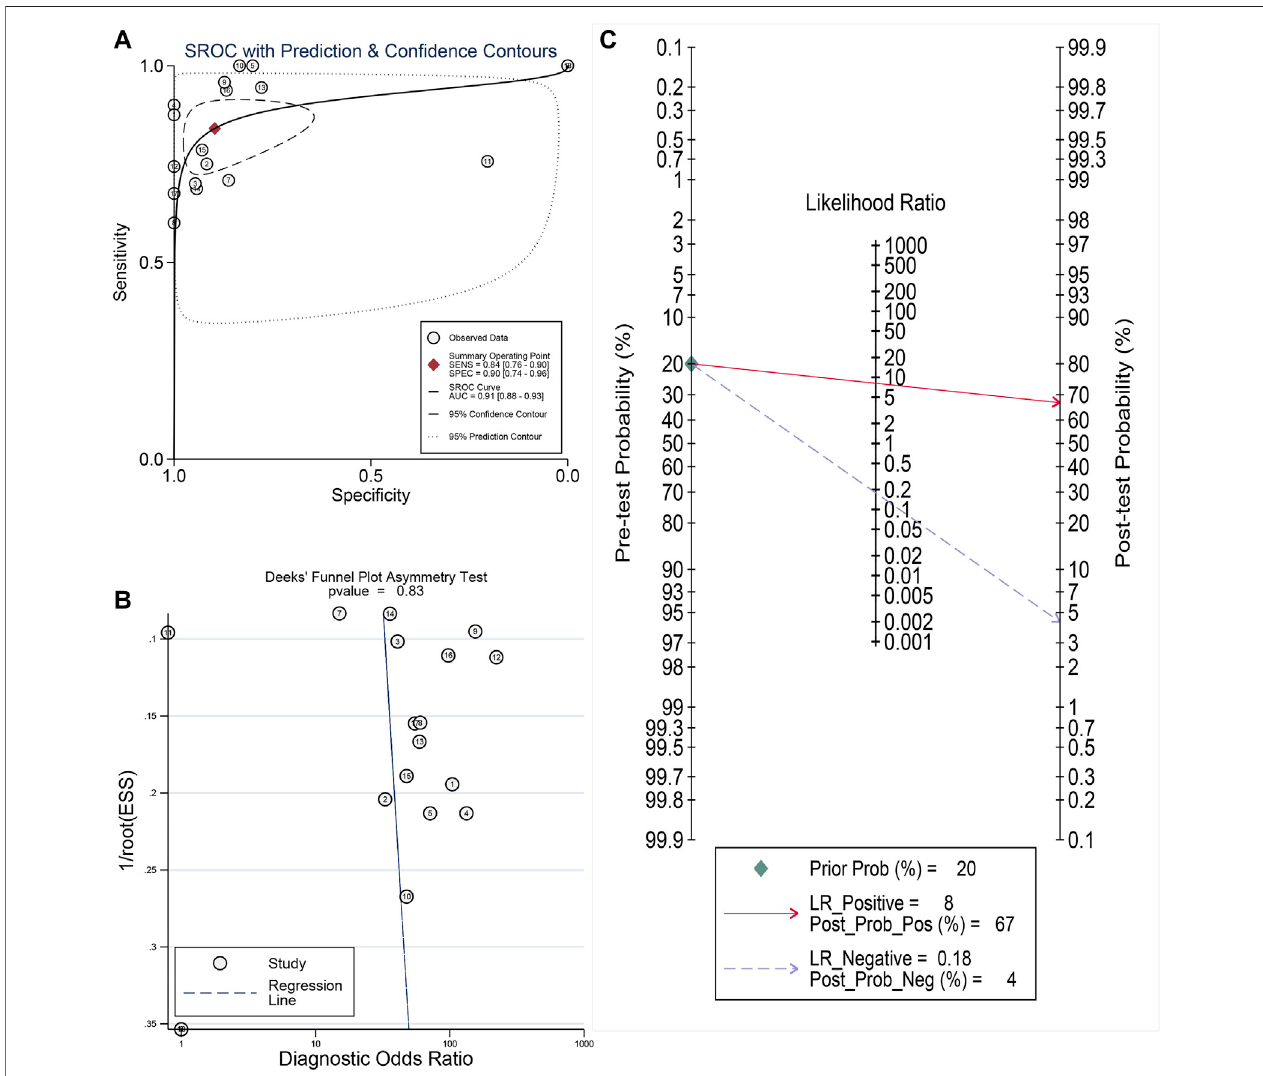
FIGURE 5 | Comprehensive analysis of the diagnostic signi fi cance of LSM4 in hepatocellular carcinoma. The summary receiver operating characteristic (sROC) curve exhibited a tremendous distinguish capacity of LSM4 in HCC and non-HCC tissues (A) . Deeks ’ Funnel Plot, p -value > 0.50, indicating no publication bias (B) . Fagan ’ s plot also addressed the diagnostic value of LSM4 for HCC patients (C)